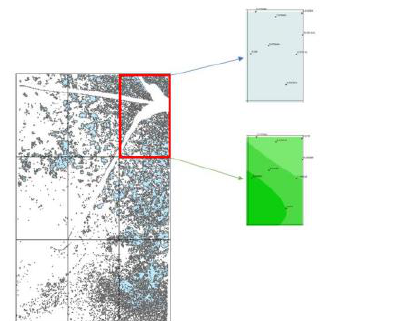
Figure 8: Application of the equation produced in OLS The values gathered in the field within the chosen grid were averaged and substituted to the equation produced in OLS. There are 8 sample points within the chosen grid, the average value for turbidity and chlorophyll-a are 5.73064525 and 4.233215375 respectively. The computed seagrass cover is 34.66% while the seagrass percent cover from the tabulate intersection tool is 31.79%. There is a deviation of 2.87%, this can be caused by the error produced in the interpolation especially in the interpolation of turbidity because of the large difference of values. The y- intercept in the equation does not necessarily mean that if the